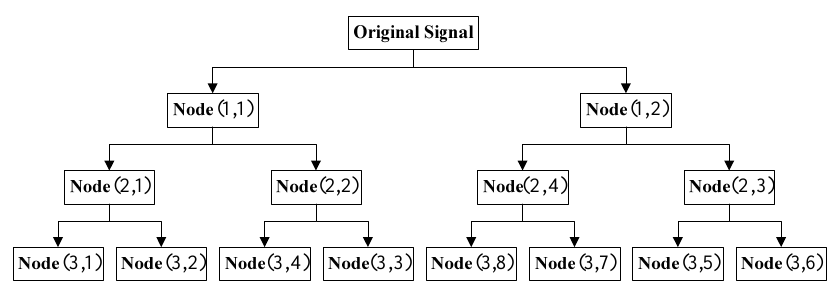
Figure 3. Node sequence in redundant lifting wavelet packet decomposition.